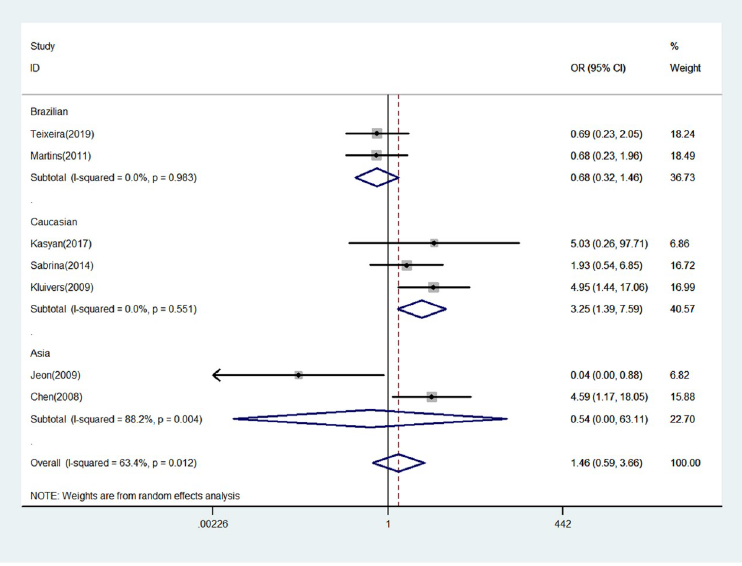
Low-Moderate heterogeneity was found under all the allele contrast ( χ 2 = 14.89, P = 0.021, I 2 = 59.7, Table 2), homozygote comparison ( χ 2 = 16.4, P = 0.012, I 2 = 63.4, Table 2), recessive genetic model ( χ 2 = 16.04, P = 0.171, I 2 = 62.6, Table 2), and dominate genetic model ( χ 2 = 9.04, P = 0.014, I 2 = 33.6, Table 2). To detect the possible source of heterogeneity, we conduct